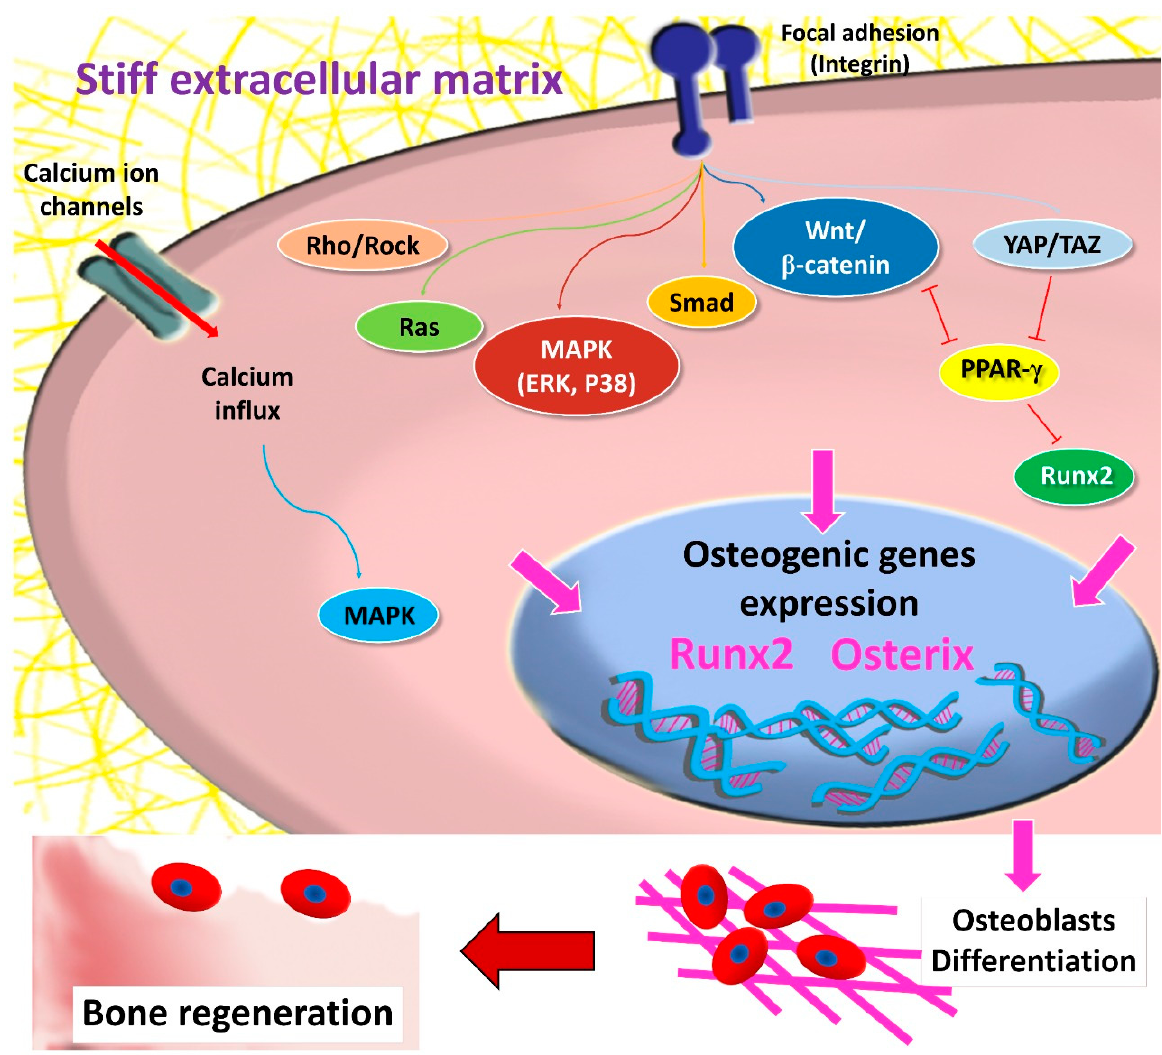
Figure 3. signaling pathways involved in stiffness induced MSCs’ osteogenic differentiation. Figure 3. Signaling pathways involved in stiffness induced MSCs’ osteogenic